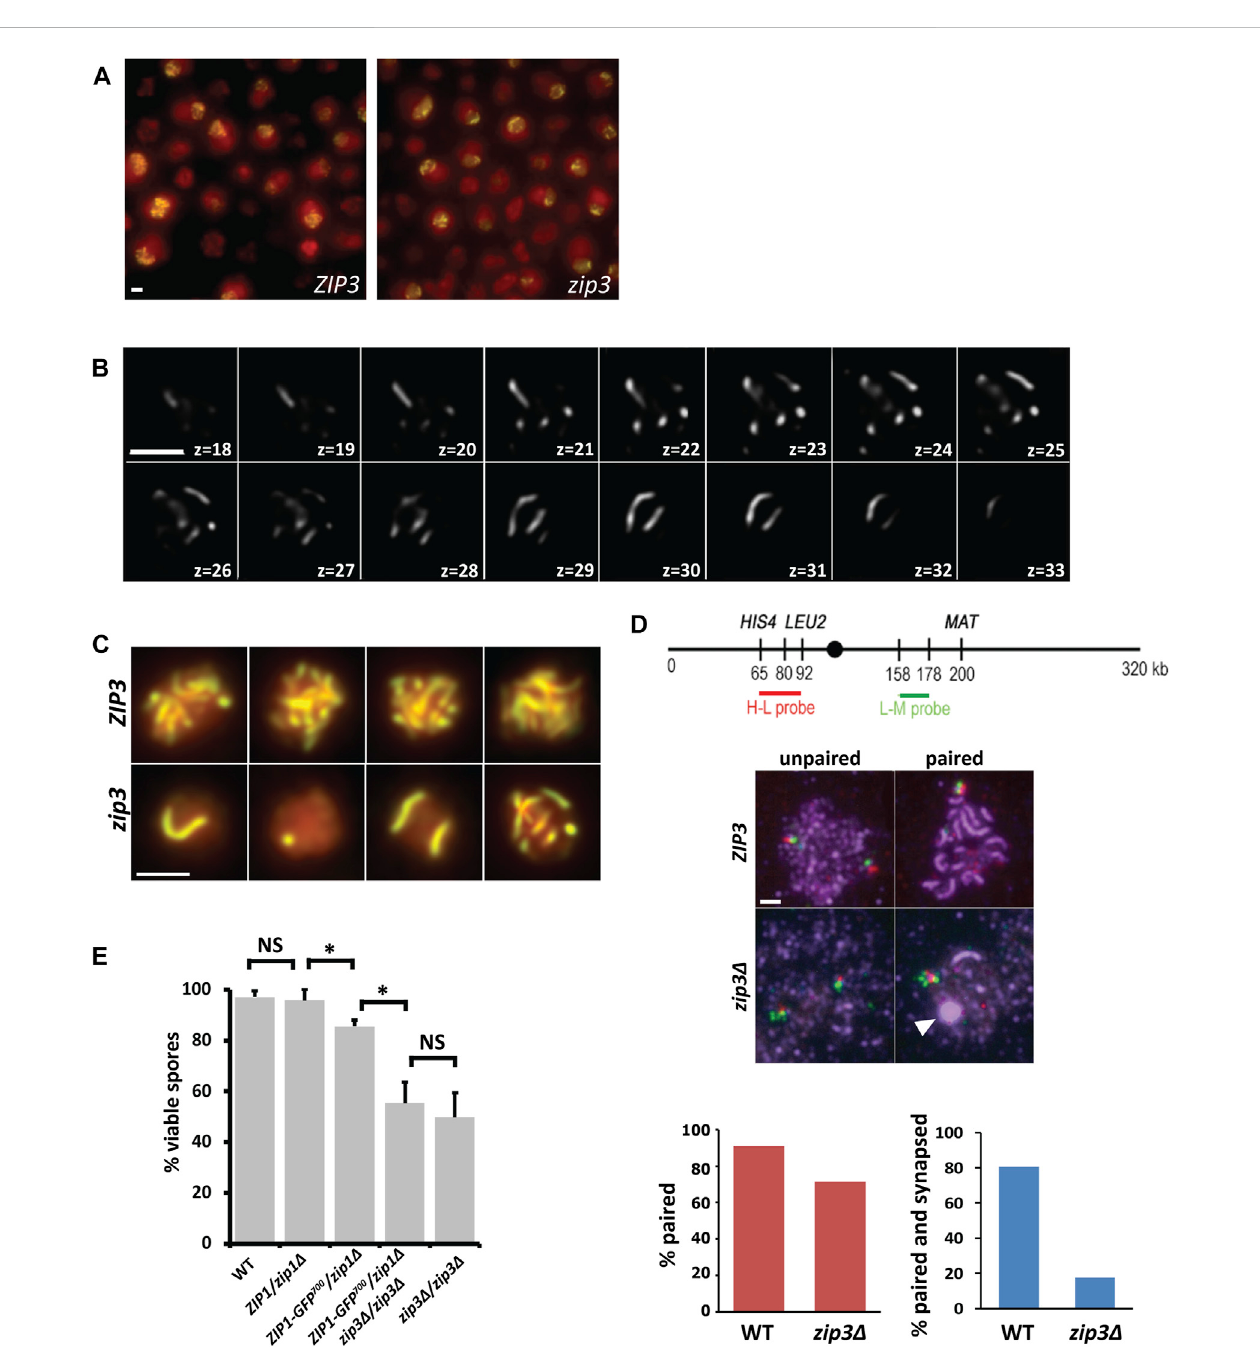
zip3 Δ improves visualization of synapsis. (A) Example of a typical acquisition fi eld of WT (left panel) and zip3 Δ (right panel) in vivo yeast cells expressing Zip1-GFP undergoing meiosis (14 h after meiotic induction) shown as a 2D max-sum projection. Zip1-GFP on synapsed chromosomes is shown in yellow. Nucleiarede fi nedbyoverallnuclearZip1-GFPsignalshowninred.Theseimagesarenotforquantitativeintensitycomparisons. (B) z-slicesevery0.2 μ mfrom 3D image stack of a nucleus containing 9 Zip1-GFP SCs in a zip3. mutant after denoising and deconvolution. (C) 2D max-sum projections of pachytene nuclei expressing Zip1-GFP in ZIP3 (top panel) compared to the equivalent stage in zip3. (bottom panel). Scale bar ― 2 μ m. (D) Top panel. Map of FISH probes madetothe HIS4-LEU2 region(H-Lprobe)andtothe LEU2-MAT region(L-Mprobe)onchromosomeIII.Middlepanel.WTand zip3 Δ pachytenechromosome spreads hybridized with H-L probes (red) and L-M probes (green) and stained with anti-Zip1 antibodies (purple) for WT and zip3 Δ (middle panel). The white arrowhead indicates a polycomplex. Scale bar 2 µm. Bottom Panel. Red graph shows the percent of HL and LM FISH probes colocalizing for WT ( n = 33) and zip3 Δ ( n = 40). The blue graph shows percent of colocalized probes that are within synapsed regions for WT and zip3 Δ . (E) Histogram of the percent of viable sporesforeachgenotype.Foreachgenotype,between120 – 170tetradsweredissected.Az-testforproportionswasusedtotestforsigni fi cance(*).Z=5.64, p < 0.00001 between ZIP1/zip1 Δ and ZIP1-GFP/zip1 Δ . Z = 5.62 p < 0.00001 between ZIP1-GFP/zip1 Δ and ZIP1-GFP/zip1 Δ zip3 Δ /zip3 Δ . NS — not signi fi cant. Error bars —